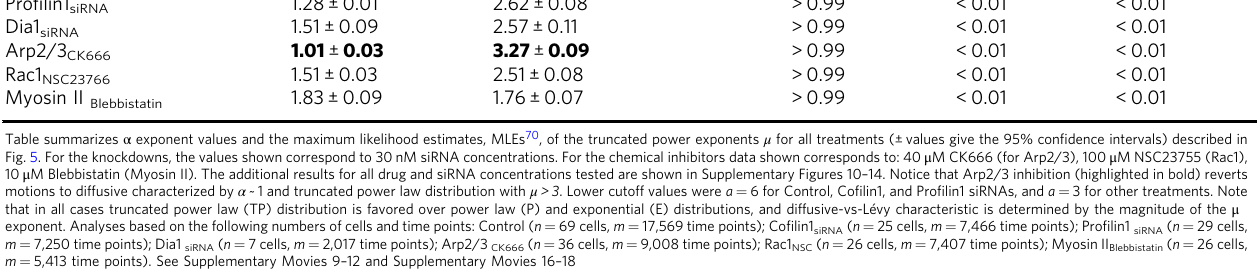
Table 3 Statistical analysis of metastatic cancer cell movements upon inhibition of actin regulators Protein